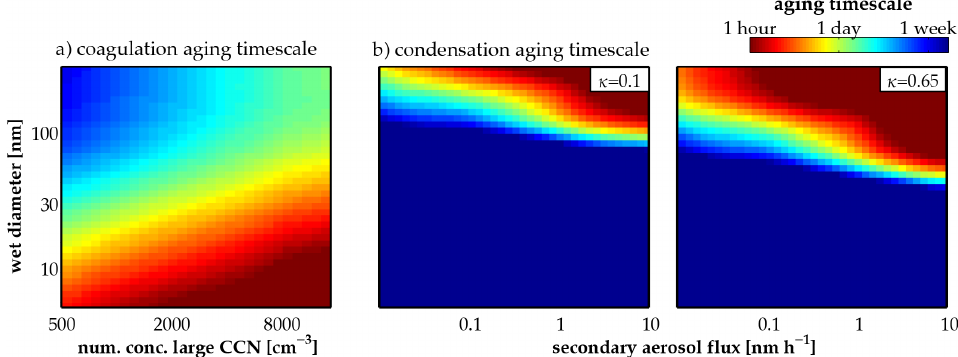
Figure 9. Coagulation aging timescale as a function of wet diameter and number of large, CCN-active particles (a) and condensation aging timescale as a function of wet diameter, secondary aerosol flux, and hygroscopicity of secondary aerosol (b) . Results are shown for a threshold supersaturation s of